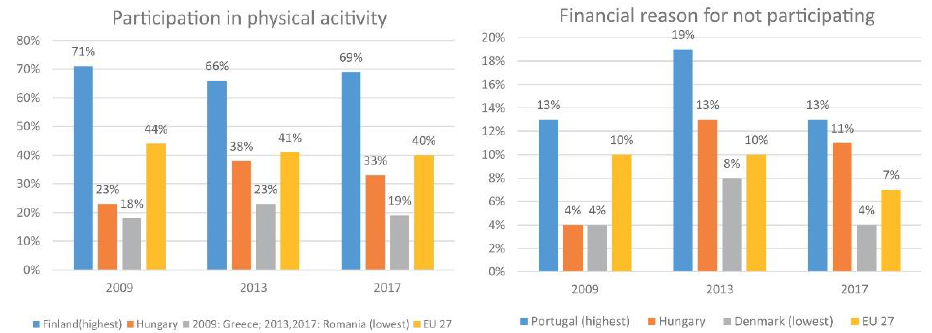
Figure 2. Participation in physical activity at least once a week or more and financial burden of physical inactivity in the EU [32–34].